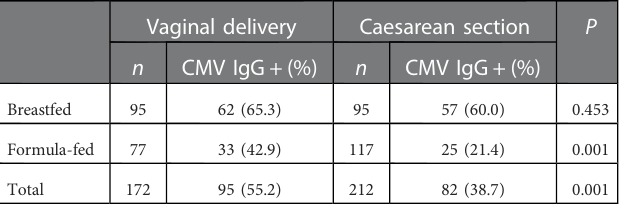
TABLE 4 Seroprevalence of cytomegalovirus (CMV) IgG in infants who were born by vaginal delivery or caesarean